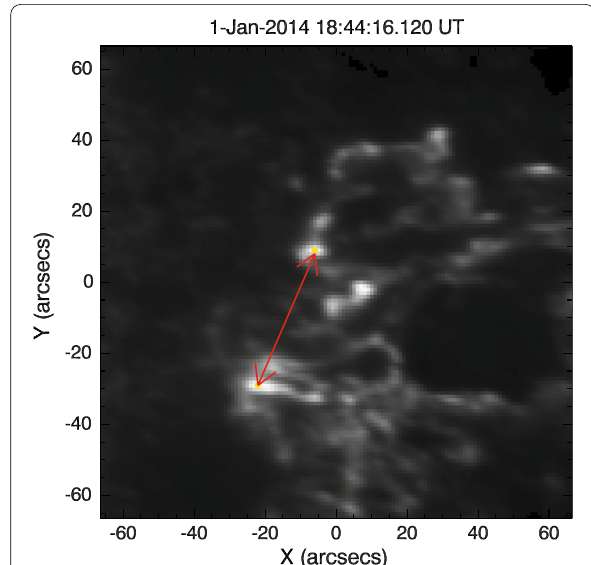
Fig. 5 Example of flare ribbon observation. The flare ribbon observation by the SDO/AIA 1600 Å for the M9.9-class flare on January 1, 2014. The yellow contour indicates the region with an intensity 40 times greater than the standard deviation of the quiet region. The red arrow indicates the ribbon distance defined in this